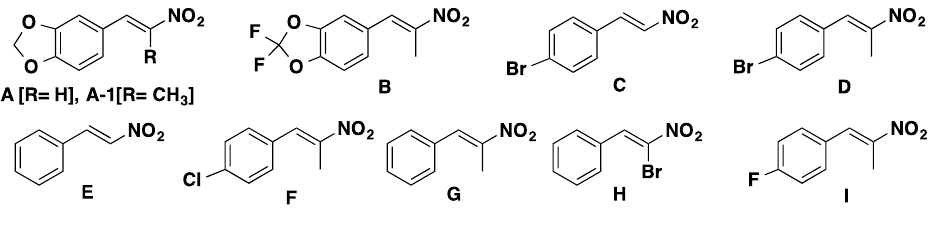
Figure 1. The structures of the E- β -nitrostyrene derivative test